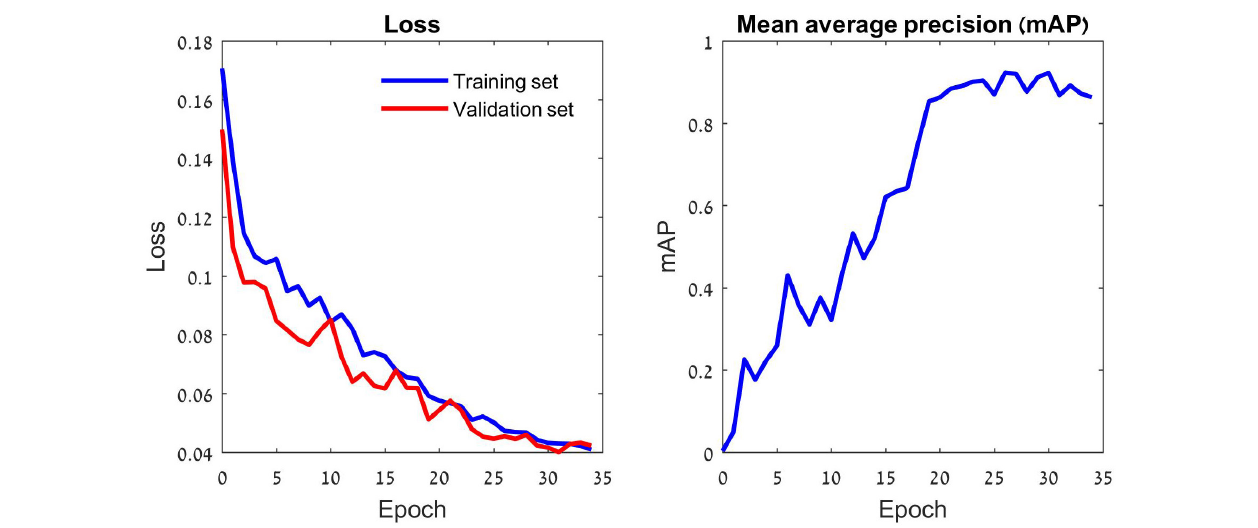
FIGURE 2 | The training process of the YOLOv5 model. The left panel depicts the loss function that drives the learning process. This function penalizes incorrect predictions of the three focal species as well as missed ones. The learning consists of iterative reduction of this penalty for the training set images (blue) by a stochastic gradient algorithm (Ruder, 2016). The validation set images (red) do not participate in the optimization and the gradual reduction in their loss indicates that the training has not reached an overfitting point. The validation loss stabilizes after 30 epochs, suggesting that further training might lead to overfitting. Thus, the deep learning model generated by 30 training epochs was used for tests. A different perspective on the gradually improving performance of the model is provided in the right panel. The model’s average precision (AP) improves with the number of training epochs. The plot depicts the model’s mean AP (mAP) over the three insect classes.